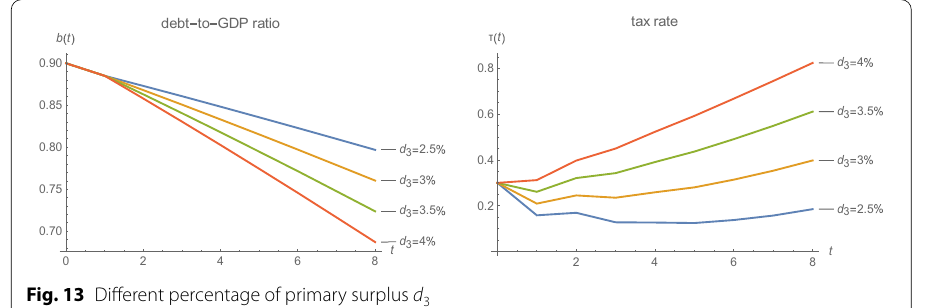
Fig. 13 Different percentage of primary surplus d 3